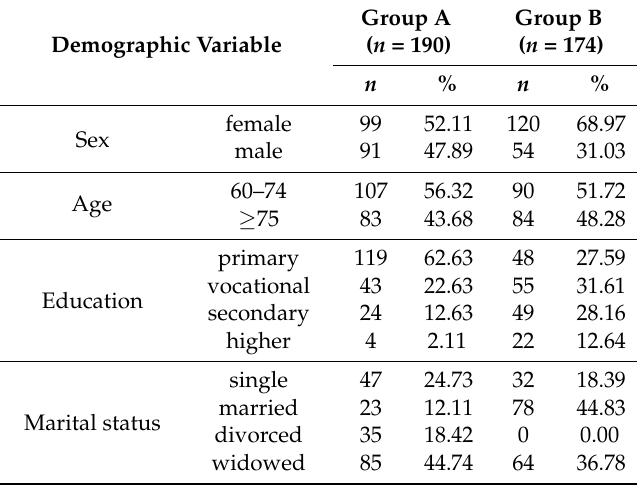
Table 1. Demographic variables in the studied